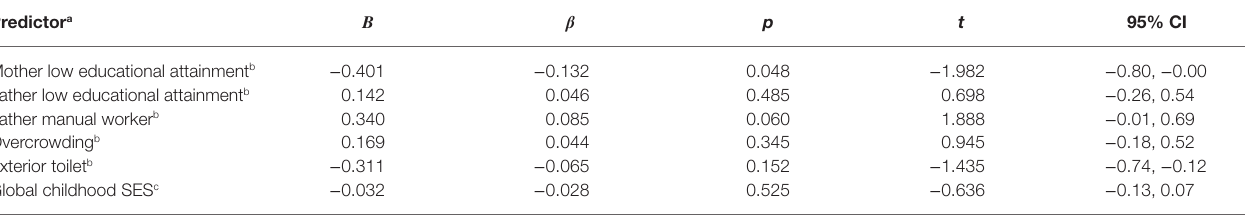
N = 519; SES, socioeconomic status; CI, confidence interval. a Dichotomous variables. b R 2 = 0.019; c R 2 =